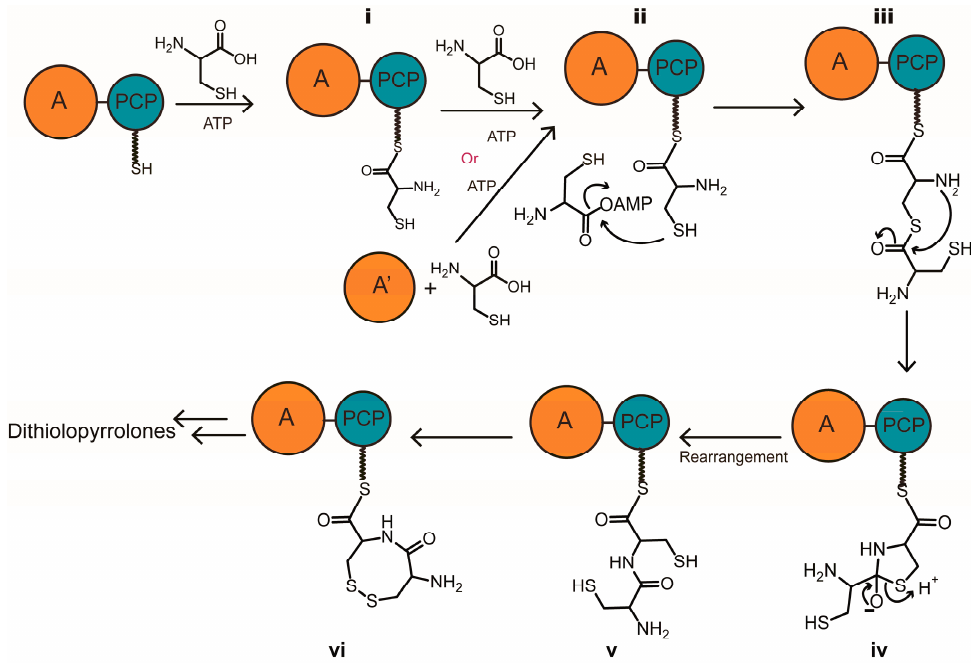
Figure 3. A proposed mechanism for the cysteine reloading process catalyzed by A domain.